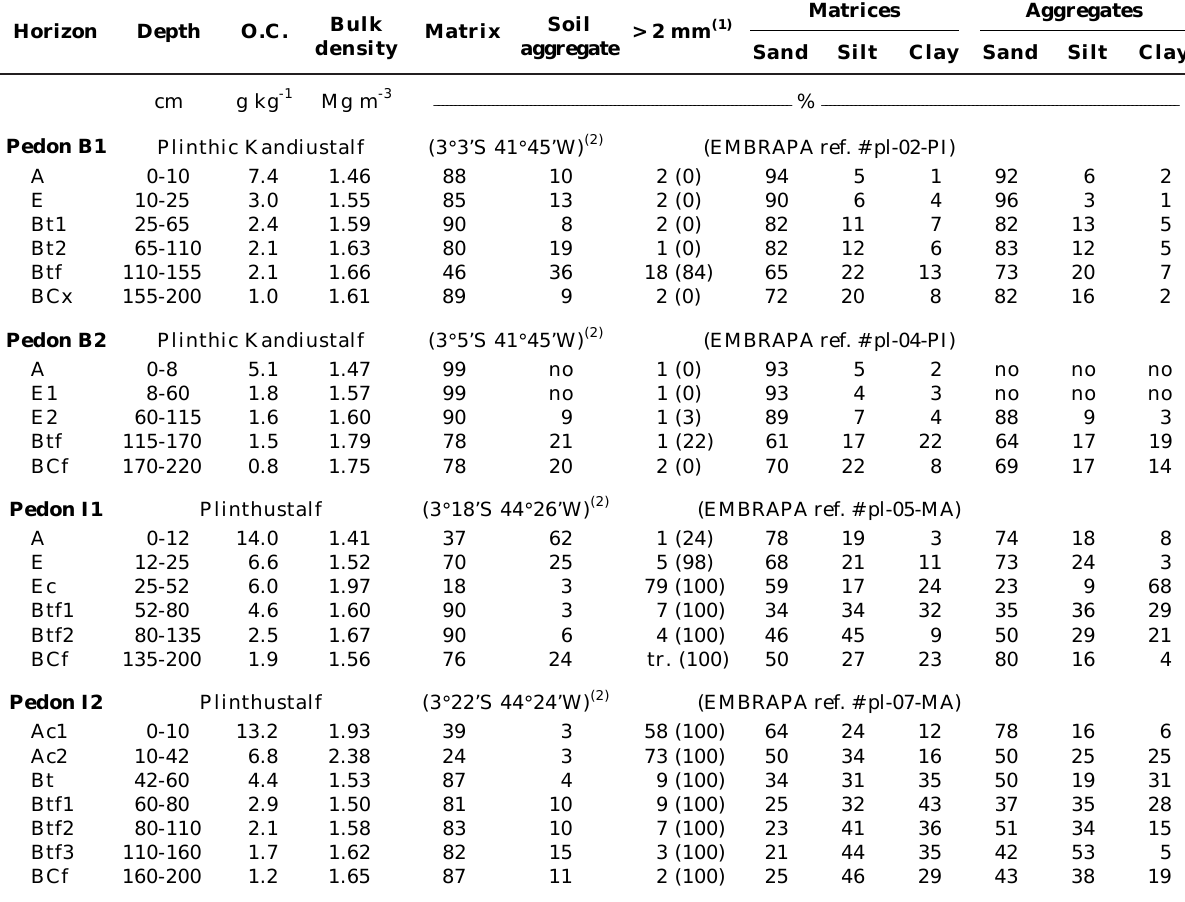
Table 1. Organic carbon content, bulk density as well as distribution of soil material among each consistency and particle size